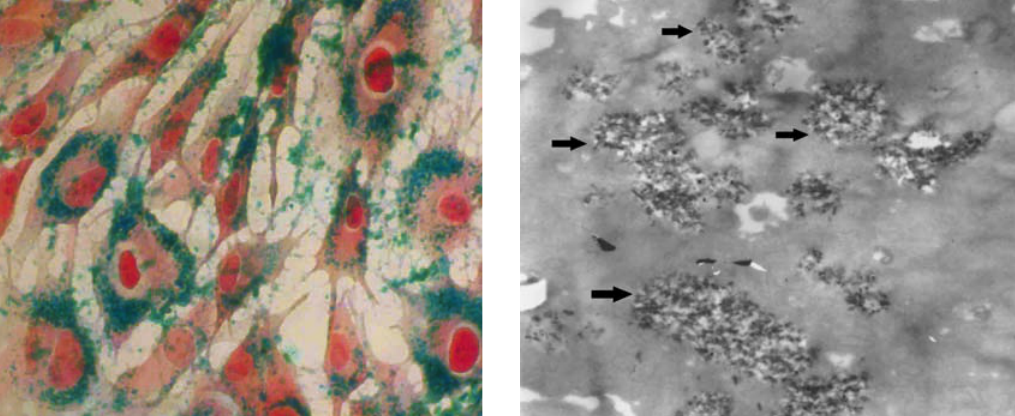
Mesenchymal stem cells (MSCs) (P3) exhibit nodular aggregation on the von Kossa staining mineral (arrows) after osteogenic induction.